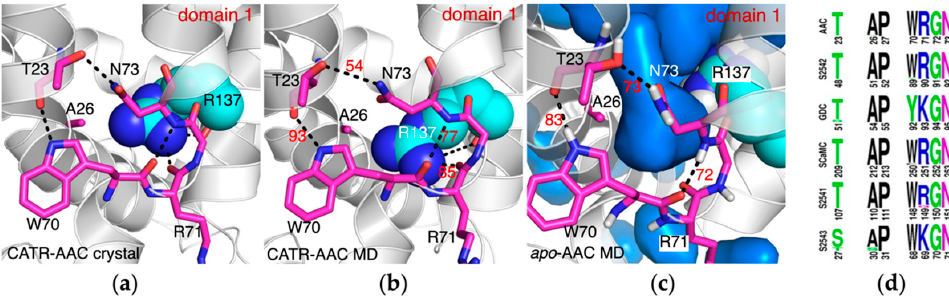
Figure 4. Conformations of R137 are quite different with and without presence of CATR. In the crystal structure ( a ) and the MD simulation structure ( b ) of CATR-AAC complex, the guanidine group of R137 binds with backbone carbonyl of R71 and fills the gap between the [YWF][KR]G motif and A26. ( c ) The gap between the [YWF][KR]G motif and A26 is filled with water molecules in the simulations on apo AAC ( wild-type AAC ). ( d ) Sequence logo of A26 and residues involved in the interaction between the [YWF][KR]G motif and Pro kink region in orthologs of AAC, SLC25A42, GDC (graves disease carrier), SCaMC (calcium-binding mitochondrial carrier protein), SLC25A41 and SLC25A43, respectively. Equivalent positions among these paralogs are aligned in the same column. The multiple sequence alignment of SLC25A43 was calculated based on 171 sequences from the UniProt database. The results of other carriers were obtained from our recent work [17]. The residues are numbered based on hAAC1 (human ADP/ATP carrier), SLC25A42, SLC25A16, SCaMC1, SLC25A41 and SLC25A43,